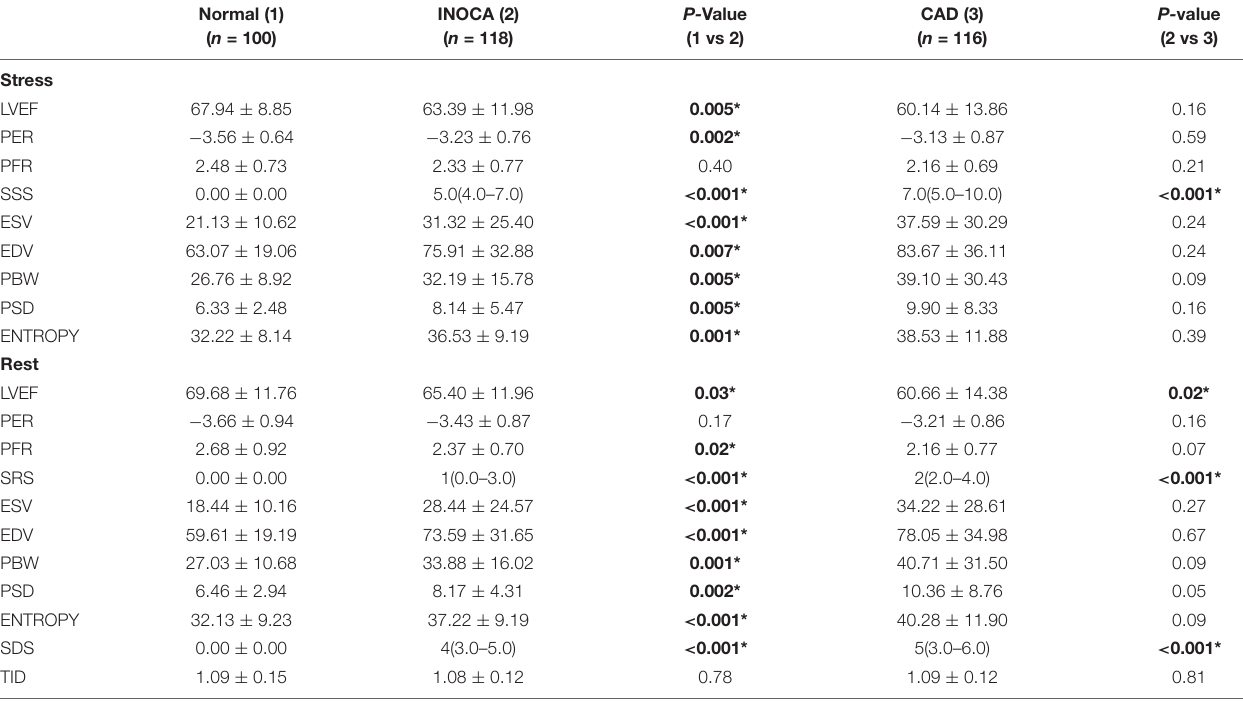
TABLE 2 | LV functions of the study population.